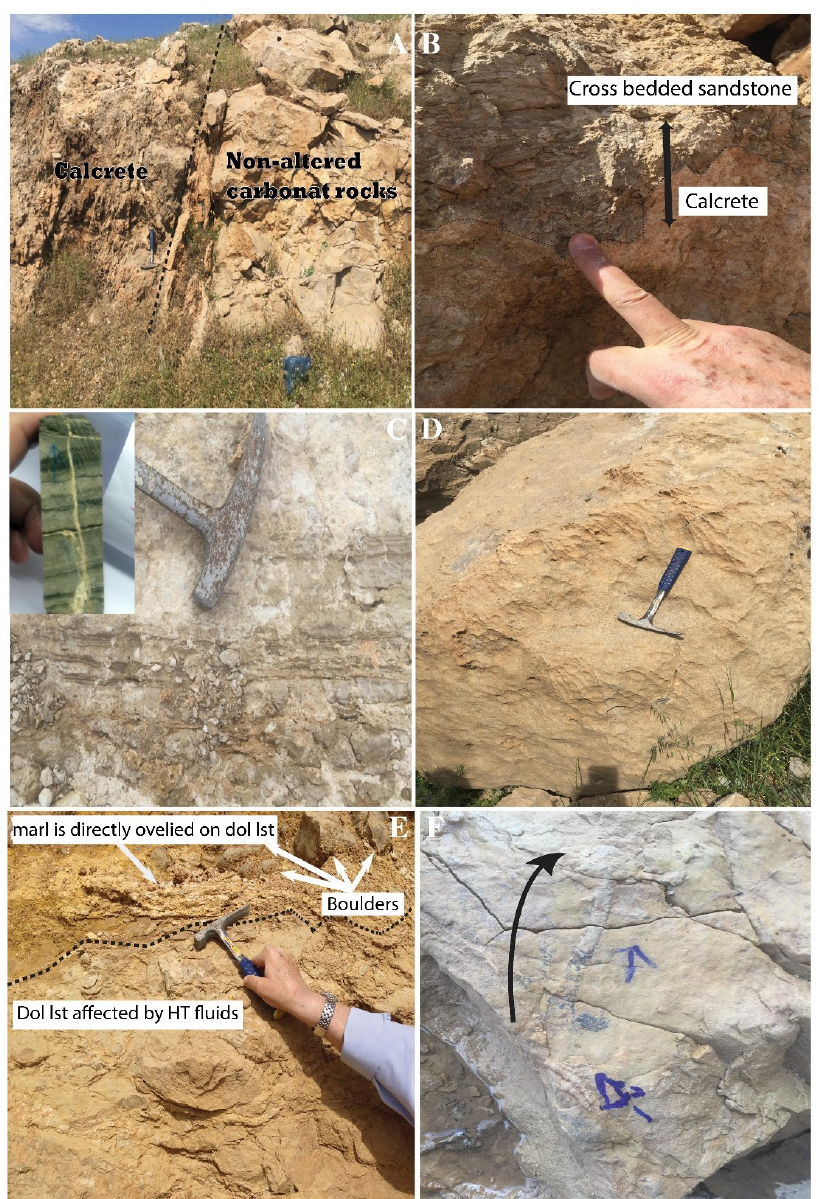
Figure 6. ( A – F ) Photographs of field and rock slabs showing the calcrete development and structures of tide-influenced in Bekhme Fm. ( A ) Abrupt contact between Bekhme Fm (right side) and the calcrete profile (left side) recording a subaerial exposure surface, probably due to tectonic uplifting. Spelek Section. ( B ) Cross-bedding of channel deposit overlying and incising the calcrete profile. The cross-beds are gently inclined and composed predominantly of a carbonate sand. Sulauk section. ( C ) Horizontal laminations with slightly undulating centimeter-thick dark-colored levels of microbial boundstone, where the lower most part is composed of cobble and pebble particles forming a fining upward thin sequence, with bioturbation on the upper left part. Sulauk section. ( D ) Rill-marks washed out by wind and water energy. Sulauk section. ( E ) Horizontal laminated crust superimposed on the upper part of Bekhme Formation, where large gray angular boulders are embedded in the softy ground mud. Sulauk section. ( F ) Biological activity on the surface of Bekhme Fm, where arrows point to a Thalassinoides burrow. Sulauk